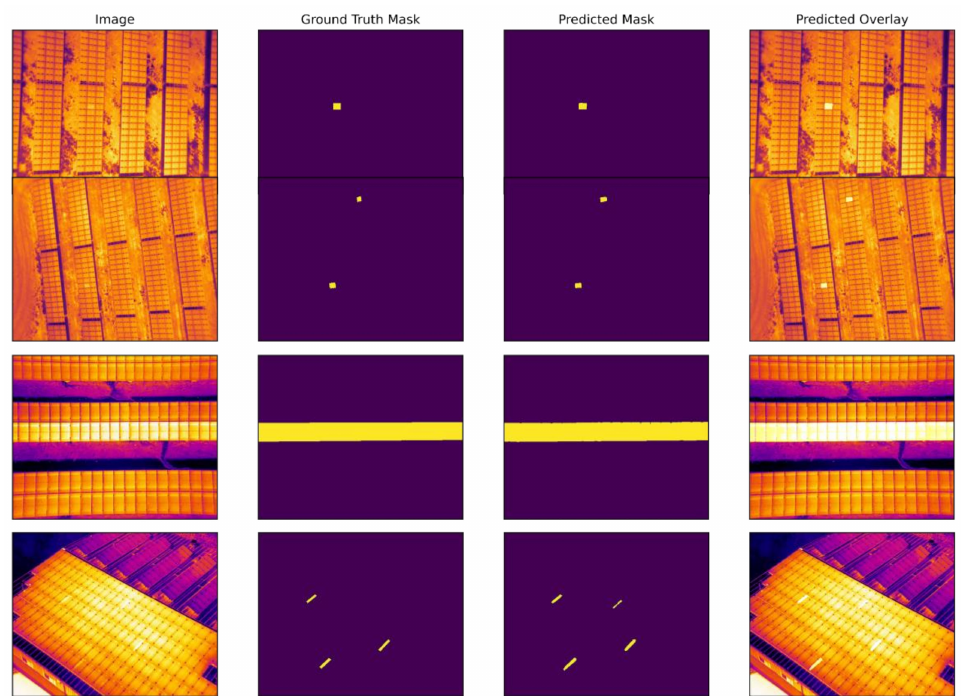
Figure 10. Original, ground-truth mask, model-predicted mask and predicted overlay images of PV plant fault detection experiment using FPN segmentation